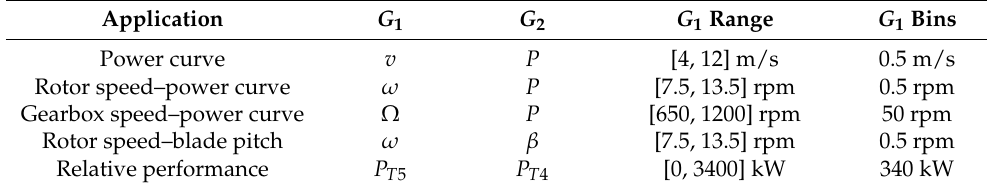
Table 1. Applications of the binning